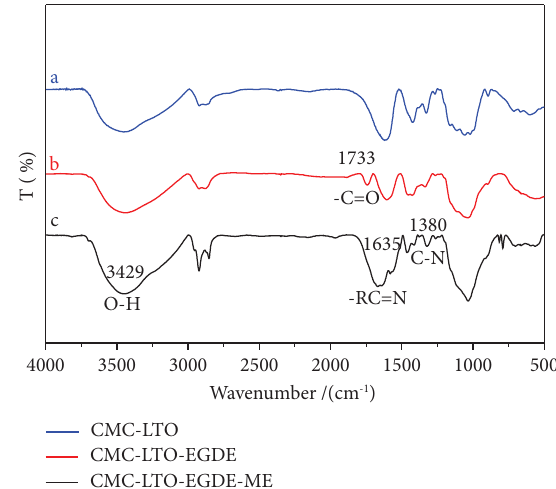
Figure 6: Comparison of FT-IR spectra: (a) CMC-LTO, (b) EGDE cross-linked CMC-LTO, and (c) ME cross-linked CMC-LTO-